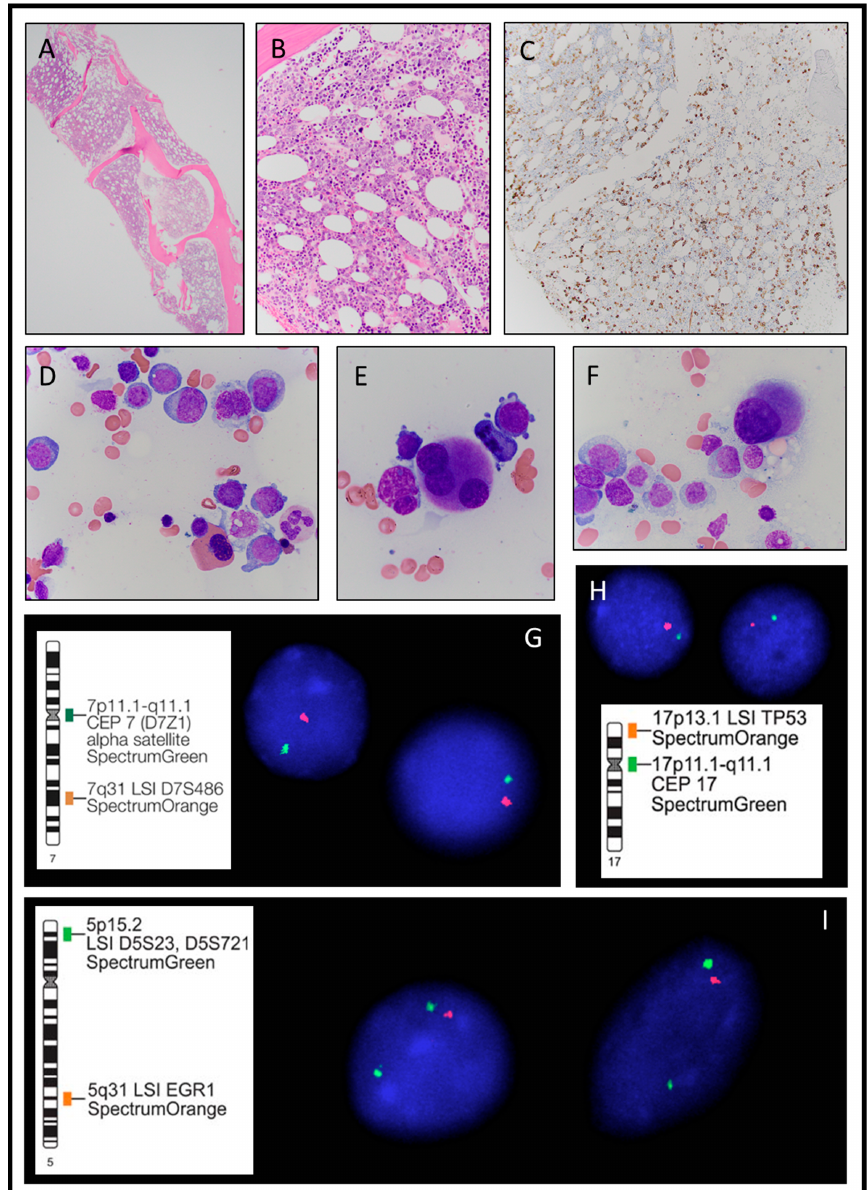
Figure 3. Case 3. ( A ) Bone marrow core biopsy with approximately 70% cellularity (2 × ). ( B ) Bone marrow core biopsy with trilineage hematopoiesis with left-shifted maturation (40 × ). ( C ) CD34 highlights excess blasts on core biopsy (10 × ). ( D ) Bone marrow aspirate with significant dyserythropoiesis and dysgranulopoiesis (100 × ). ( E ) Dysplastic micromegakaryocyte with small hypolobated nucleus (100 × ). ( F ) Dysplastic small megakaryocytes with disjointed nuclear lobes (100 × ). ( G ) Fluorescence in situ hybridization (FISH) analysis with Abbott Molecular D7S522 and CEP7 dual color probe set (Spectrum Orange directly labeled D7S522 probe for the 7q31 region and Spectrum Green directly labeled probe for the centromeric region of chromosome 7) detects monosomy 7. ( H ) Fluorescence in situ hybridization (FISH) analysis with the Abbott Molecular TP53 and CEP17 dual color probe set (Spectrum Orange directly labeled probe for the TP53 gene on 17p13 and Spectrum Green directly labeled probe for the centromeric region of chromosome 17, consistent with loss of the centromere of chromosome 17 and deletion of the TP53 gene. ( I ) Fluorescence in situ hybridization (FISH) analysis with the Abbott Molecular EGR1 dual color probe set (Spectrum Orange directly labeled probe for the EGR1 gene on 5q31 and Spectrum Green directly labeled probe for D5S23/D5S721 on 5p15.2) detects deletion of the 5q31